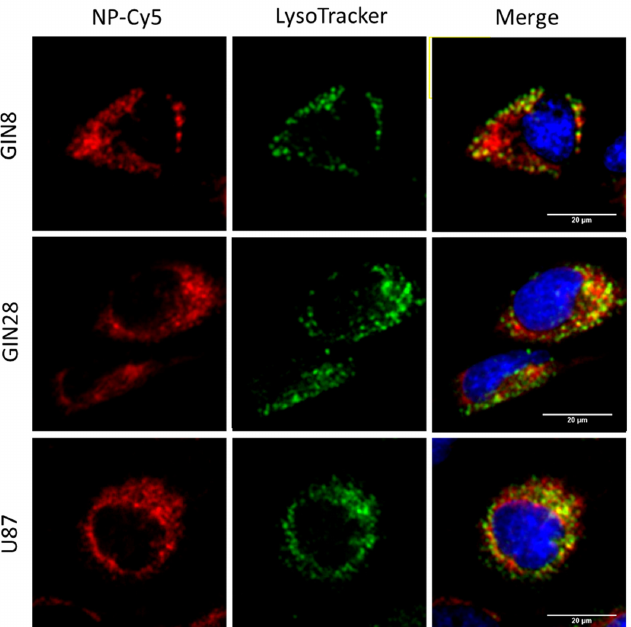
Figure 5. Assessment of NP-Cy5 uptake kinetics in GIN8, GIN28 and U87 cell lines using the fluo- rometric method. Cy5-NP P2 was applied at 50 µg/mL in 10% ( v / v ) containing DMEM. Data pre- sented as the mean ± S.D ( n = 3).